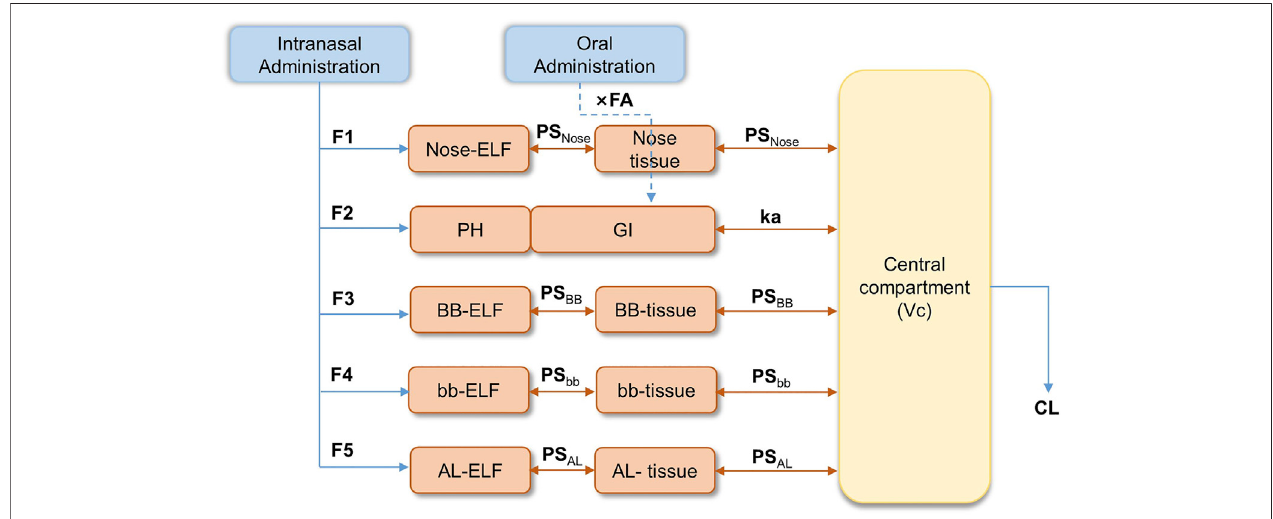
FIGURE 1 | Semi-PBPK model structure for the human respiratory system. (F1-F5: fraction of drug entering the epithelial lining fl uid (ELF); Nose-ELF: nasal cavity; PH: pharynx; BB-ELF: bronchi; bb-ELF: bronchioles; AL-ELF: alveoli; PS: permeation elimination rate; PS Nose : PS in the nasal cavity; PS BB : PS in bronchi; PS bb : PS in bronchioles; PS AL : PS in alveoli; K mcc, bb : the peristalsis of respiratory epithelial cilia between bb-ELF and BB-ELF; K mcc, BB : the peristalsis of respiratory epithelial cilia between BB-ELF and PH.).